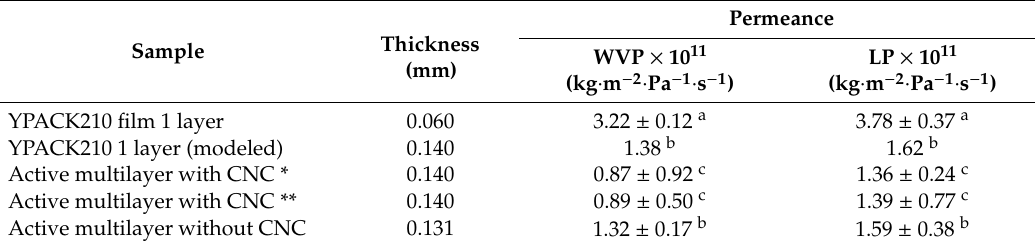
Table 2. Thickness and permeance values in terms of water vapor permeance (WVP) and D -limonene permeance (LP) of the YPACK210 film and active multilayer films with and without cellulose nanocrystal (CNC)